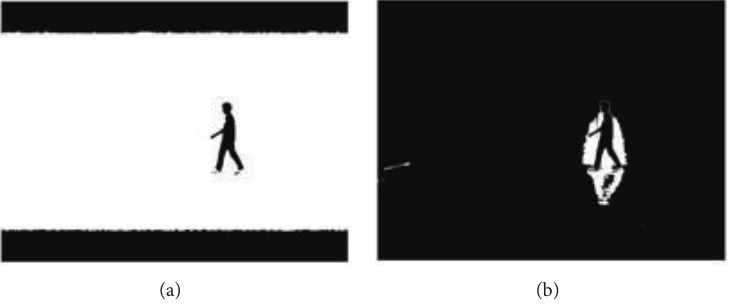
Figure 5: Highlighting brightness difference around moving foreground pixels.